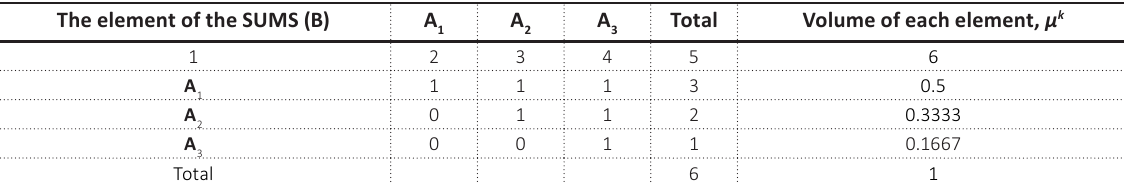
Table 6. Comparison of elements The element of the SUMS (B)